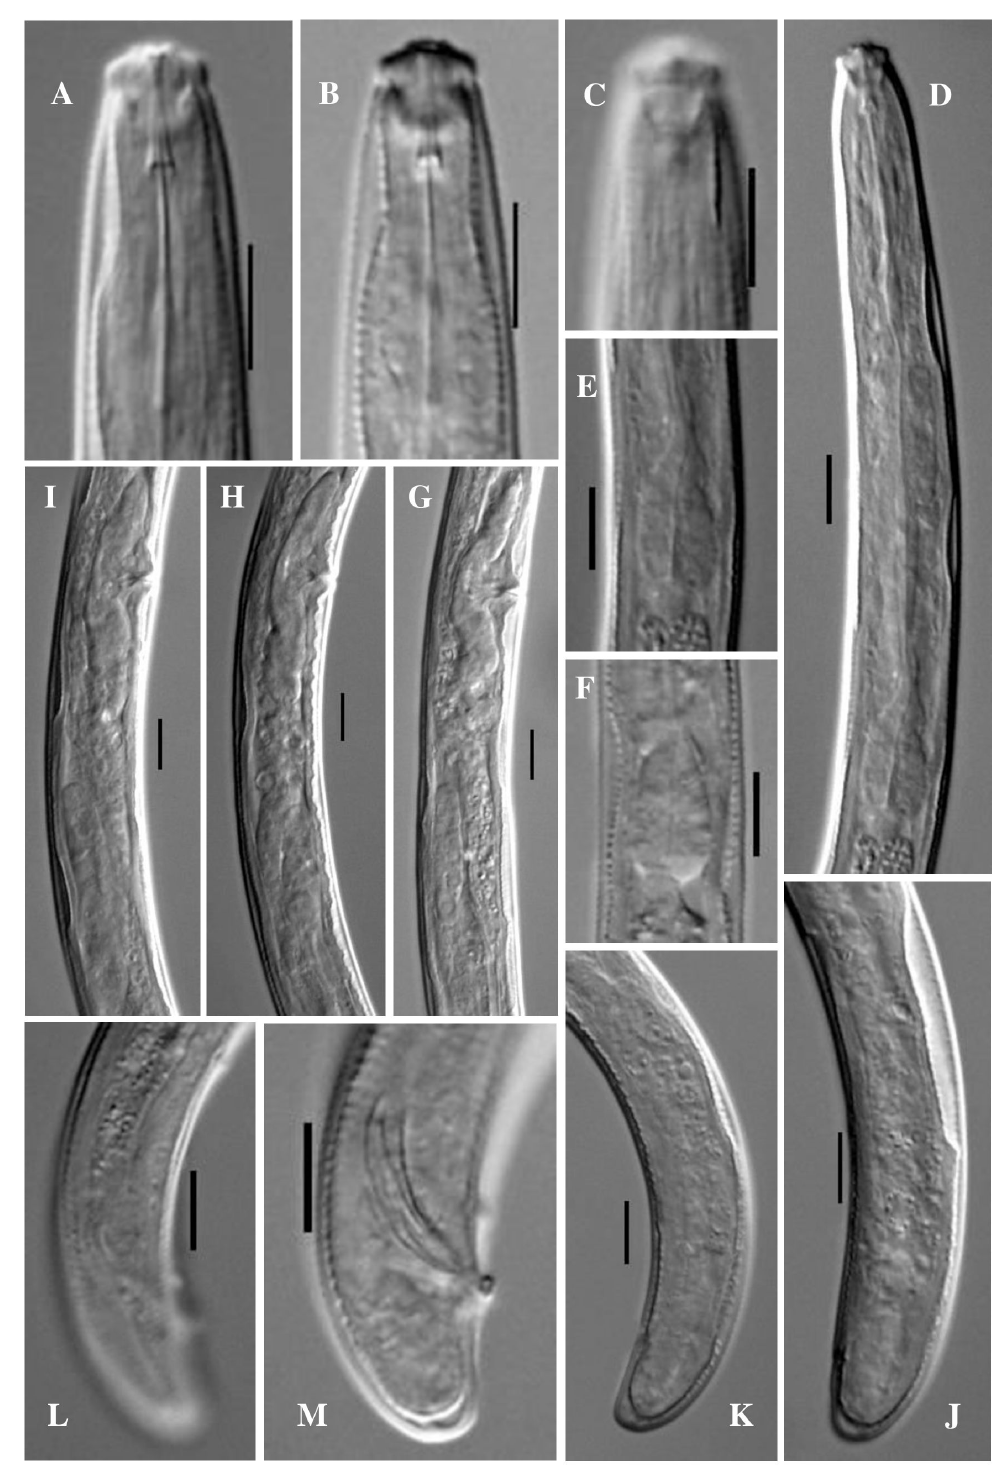
Fig. 1. Basirotyleptus basiri Jairajpuri, 1964 (AMU/ZD/NC/ Basirotyleptus basiri /1–3) (LM photographs). A – B . Female, anterior region. C . Female, anterior region showing amphid. D . Female, pharyngeal region. E – F . Female, pharyngeal bulb. G – I . Female, genital system. J – K . Female, posterior region. L – M . Male, posterior end. Scale bars = 10